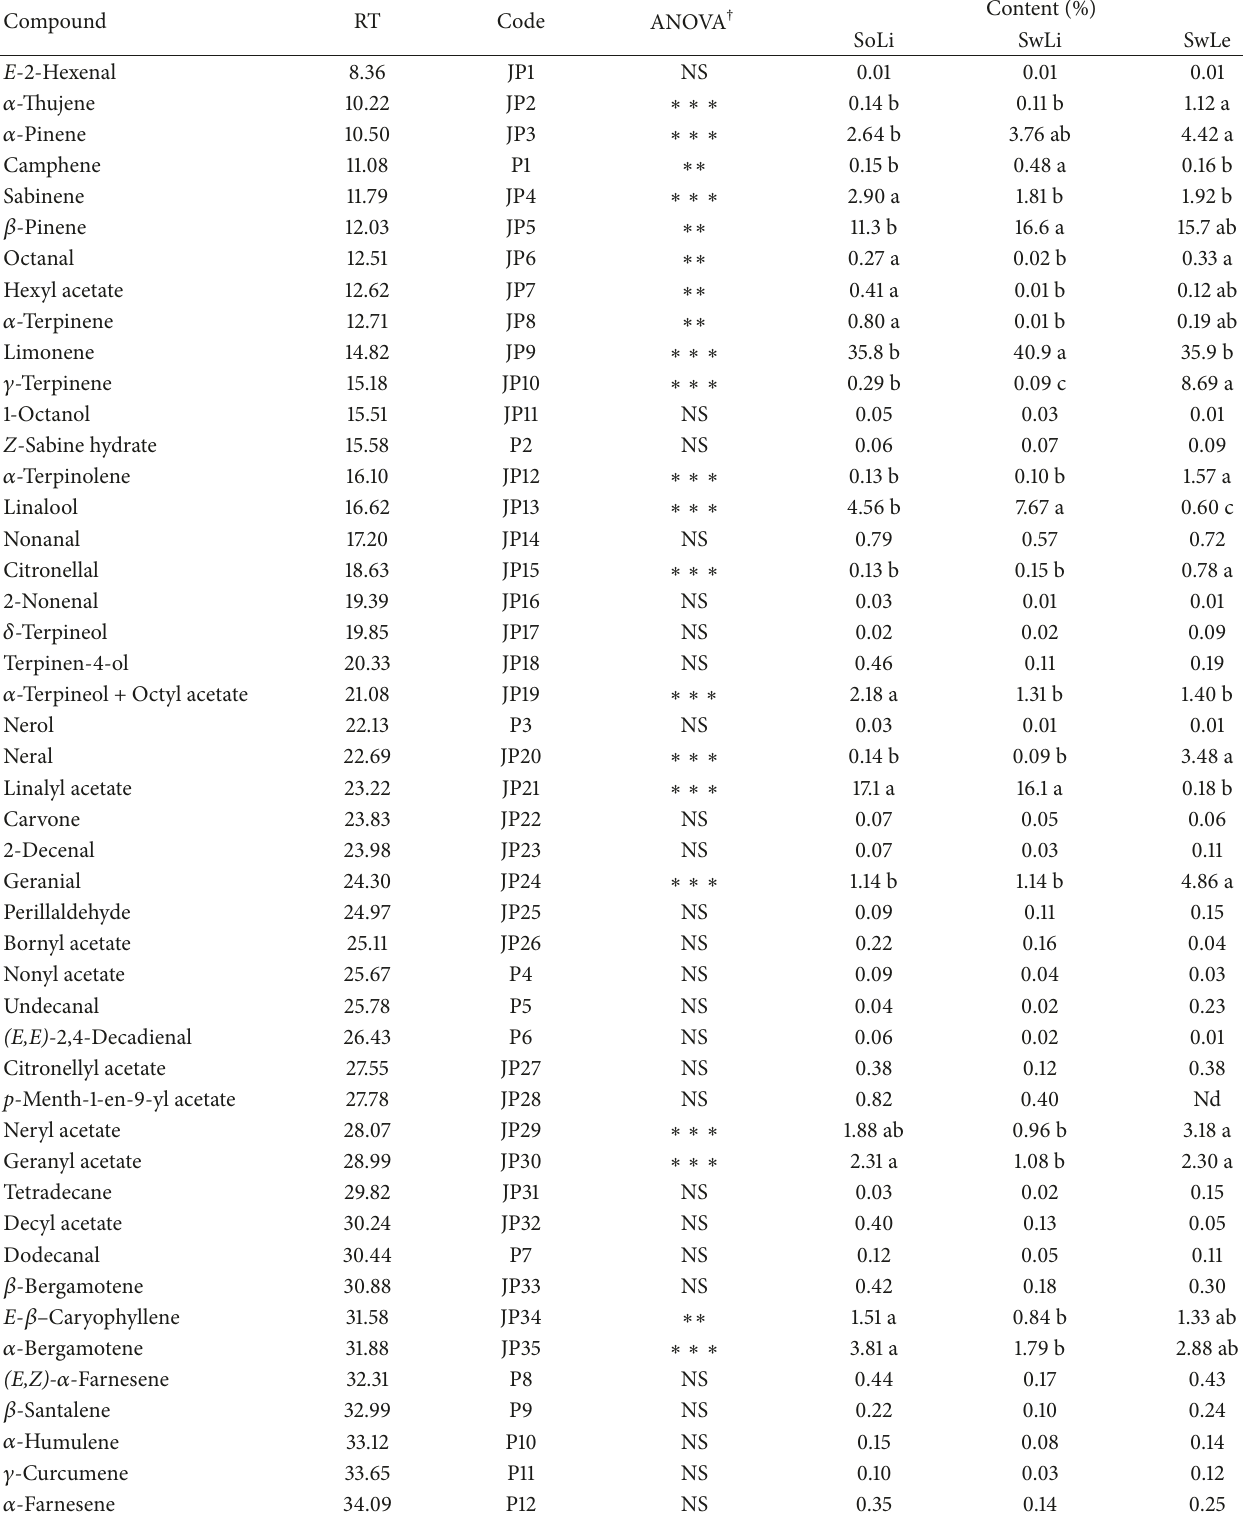
Table 5: Volatile compounds (%) in the peel of endangered Spanish sour (SoLi) and sweet (SwLi) limes and sweet lemon (SwLe).